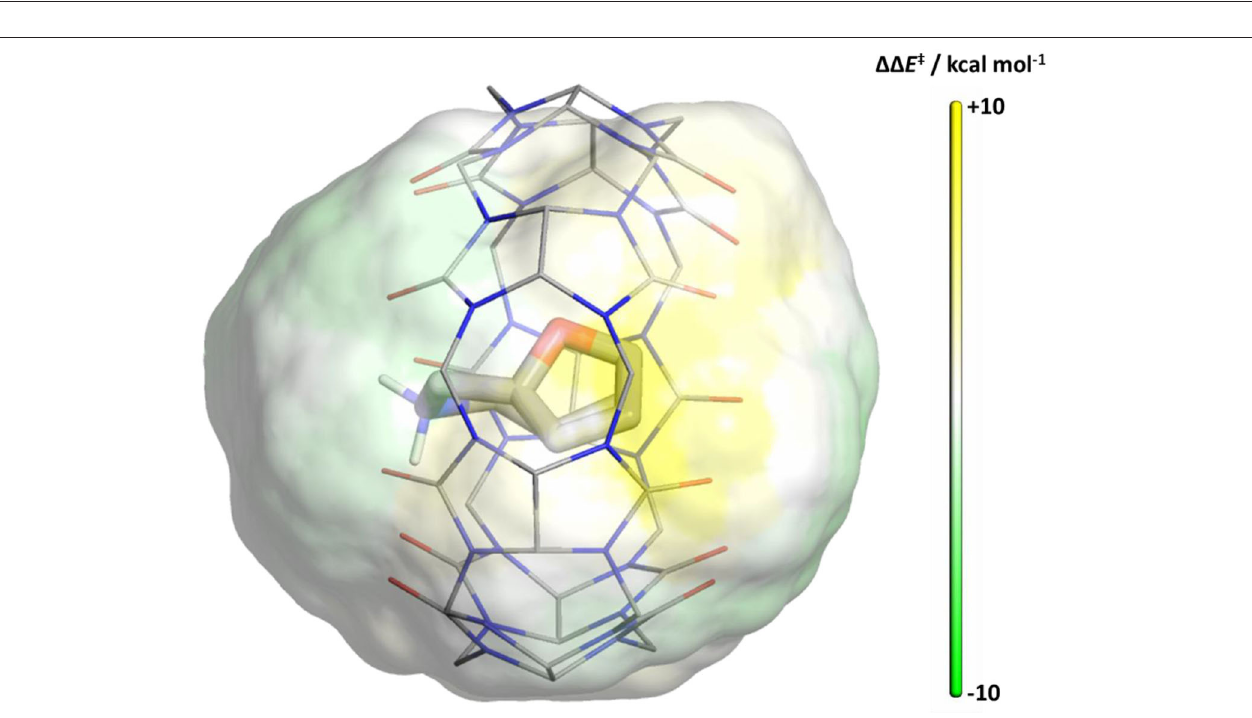
FIGURE 6 | Map of reaction barrier changes upon the addition of a probe − 1 point charge (calculated at B3LYP/6-31 + G*). Yellow regions indicate an increased barrier height for the reaction, whereas green regions favor nucleophilic groups at these locations for reducing the barrier heights as shown in color scale (capped at ± 10 kcal/mol). CB[7] is overlaid with the results to highlight the area shielded from the polar environment.